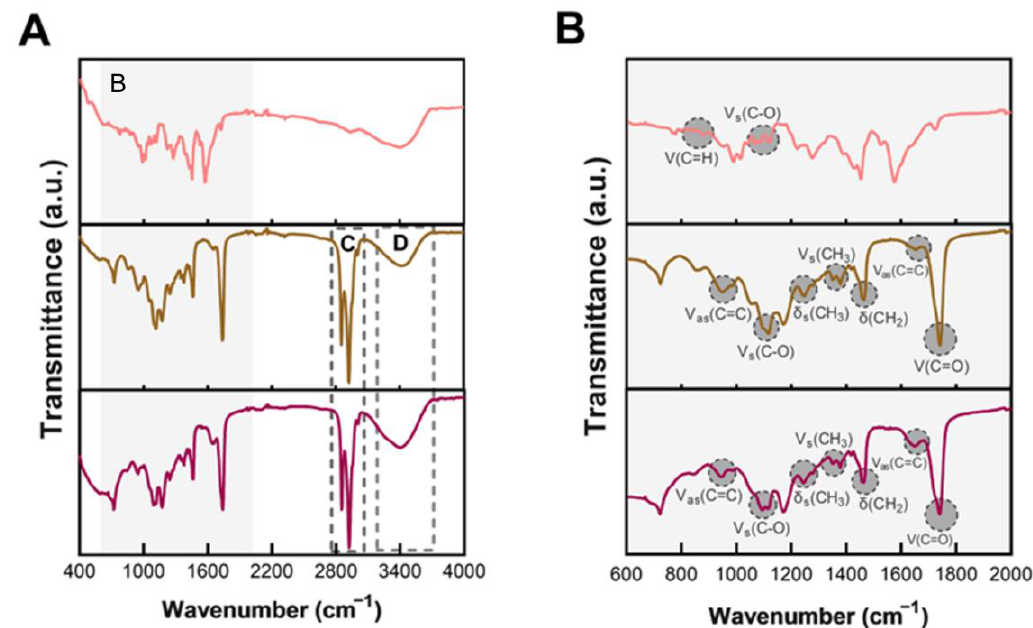
Figure 8. ATR-FTIR spectra of free DOX (pink data — upper spectrum), empty LNLCs (dark yellow data — middle spectrum) and DOX-LNLCs (magenta data — lower spectrum). The shaded area highlights the characteristic functional groups ( A ). Regions B, C (typical vibrations of the chemical groups Vs(CH 2 ) at 2860 cm − 1 and Vas(CH 2 ) at 2930 cm − 1 present in this type of nanoassemblies), and D (v(OH) band between 3200–3400 cm − 1 assigned to the O-H stretching mode of water, GMO, and P407) are assigned to the regions where functional groups are highlighted. ( B ) Maximization of shaded area (band B). V = stretching vibrations (bond vibrations); δ = deformation vibrations (bending vibrations); s = symmetric; as =